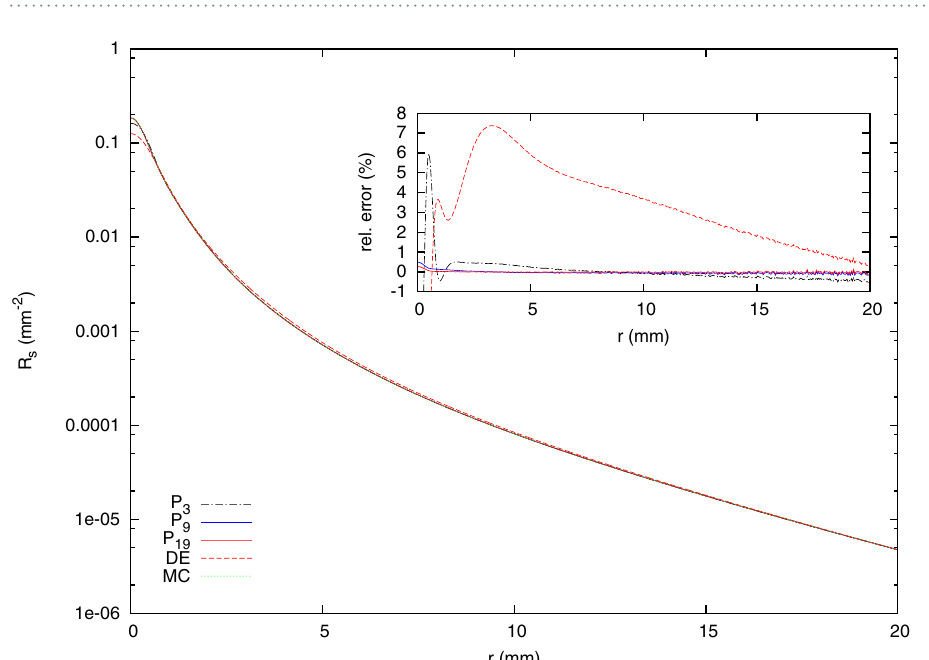
Figure 4. Steady-state spatially resolved reflectance from the three-layered scattering medium with an absorption coefficient of the lower semi-infinite layer of µ = . − 0 02mm to a perpendicularly incident Gaussian beam with a beam radius of ρ w = 0.5 mm. The refractive index of the surrounding medium is n 0 = 1.0. For N ≥ 9, the Monte Carlo simulation and the P N solution agree well. For the Monte Carlo simulation, 10 11 Photons were